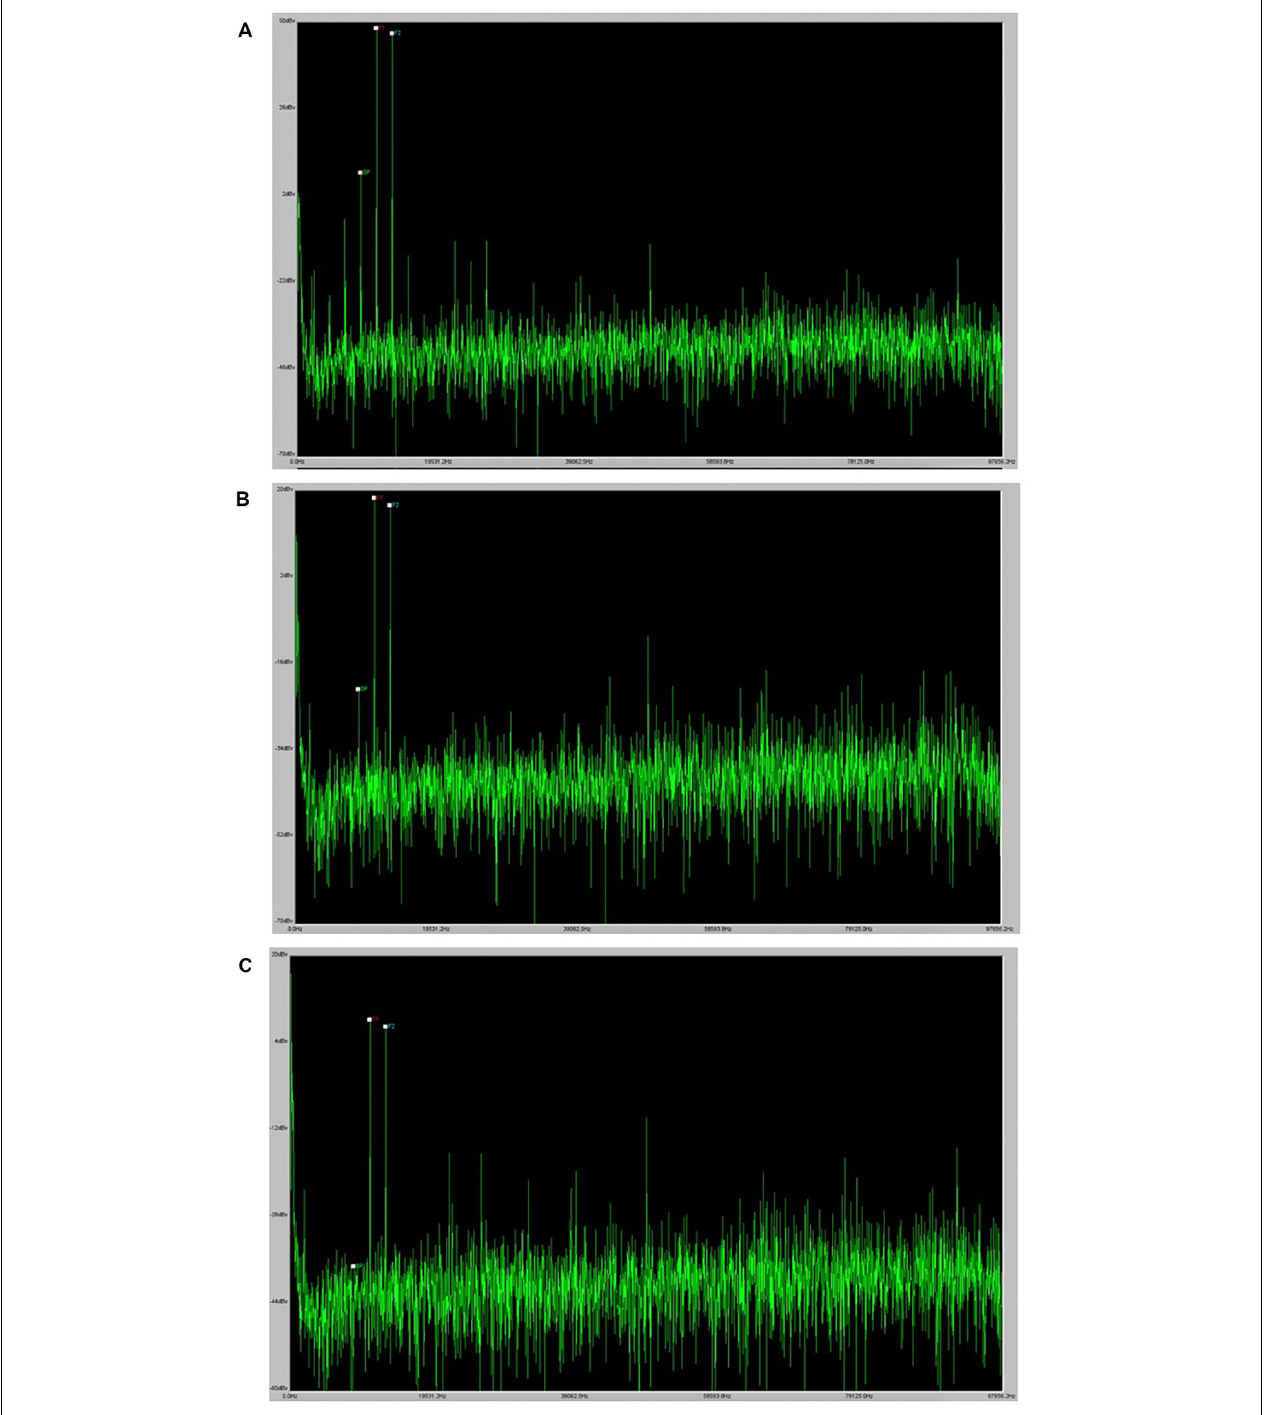
FIGURE 1 | DPOAE example. Panel (A) provides an example of a robust DPOAE as it displays in the BioSig software. Panels (B) and (C) provide examples of the visual indication of a DPOAE at the threshold and the absence of a DPOAE at lower levels.